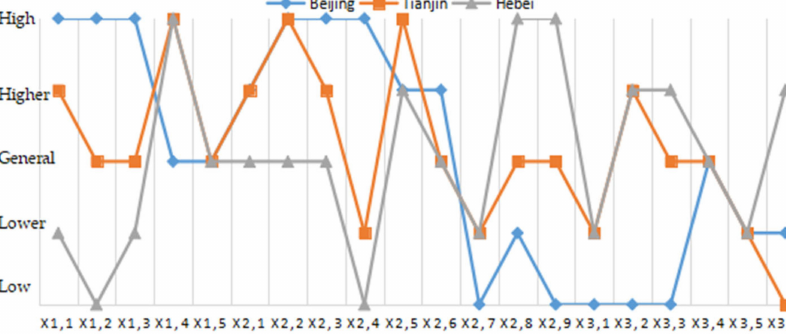
Figure 10. 2019 Beijing-Tianjin-Hebei comparison of evaluation ratings for each